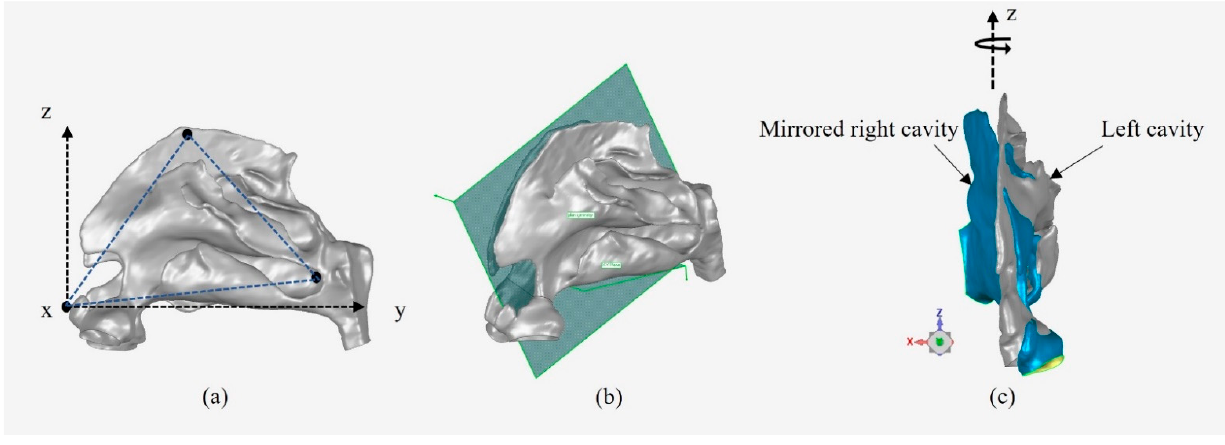
Figure 3. ( a ) Side view of 3D Coordinate system restriction key points. The black dashed line represents the horizontal and vertical planes, and the blue dashed line is the Y-Z Plane. ( b ) The symmetry plane and the X-Y plane, from an oblique angle of view. ( c ) Schematic diagram of the lateral wall alignment method. This model was rotated around the Z axis until the maximum overlap choana region was viewed from the front view of the